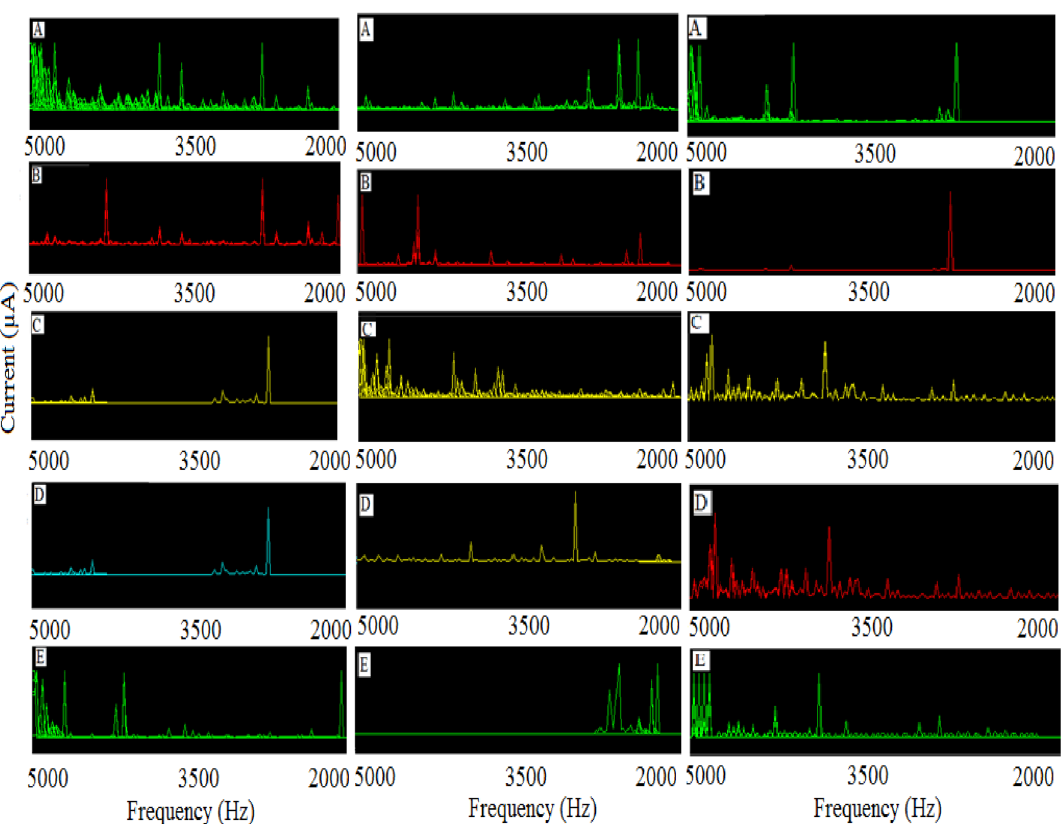
Figure 6. Spectra of ( A ) Real part, ( B ) Imaginary part, ( C ) Magnitude, ( D ) Phase and ( E ) Power spectrum for left column) Cysticercus tenuicollis, middle column) Hydatid cyst and right column) C. cerebralis. Triggered electrical potential: + 1.50 (± 0.01) V (vs. the pseudo reference probe). Time interval: 5.0 min. Inter-electrode distance: 0.50 cm, frequency step: 2 Hz.